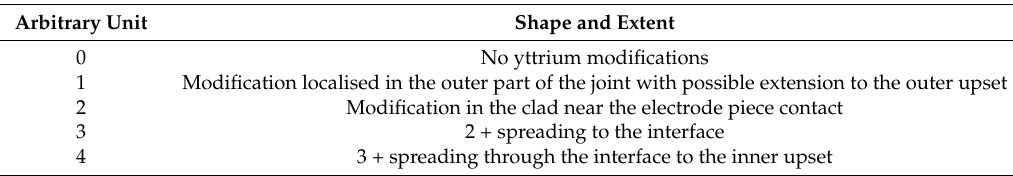
Table 3. Classification used for the yttrium distribution modification.